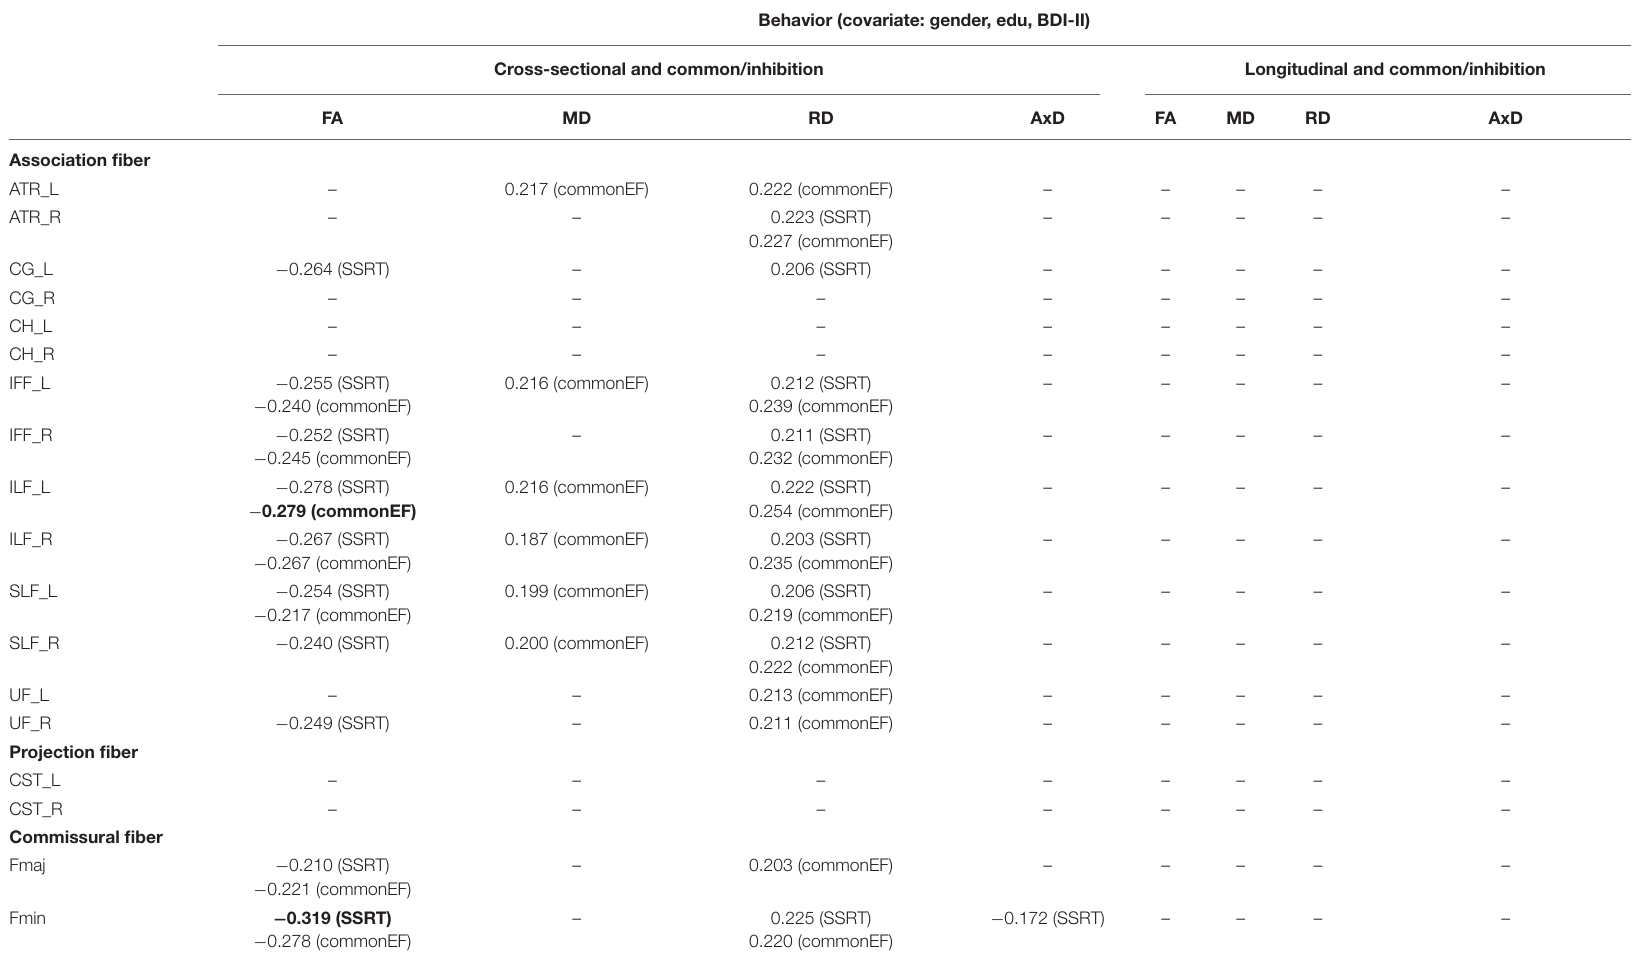
TABLE 5 | The significant Pearson correlation r values for the common/inhibition component in relation to DTI measures (FA, MD, RD, and AxD) for cross-sectional and longitudinal ratio